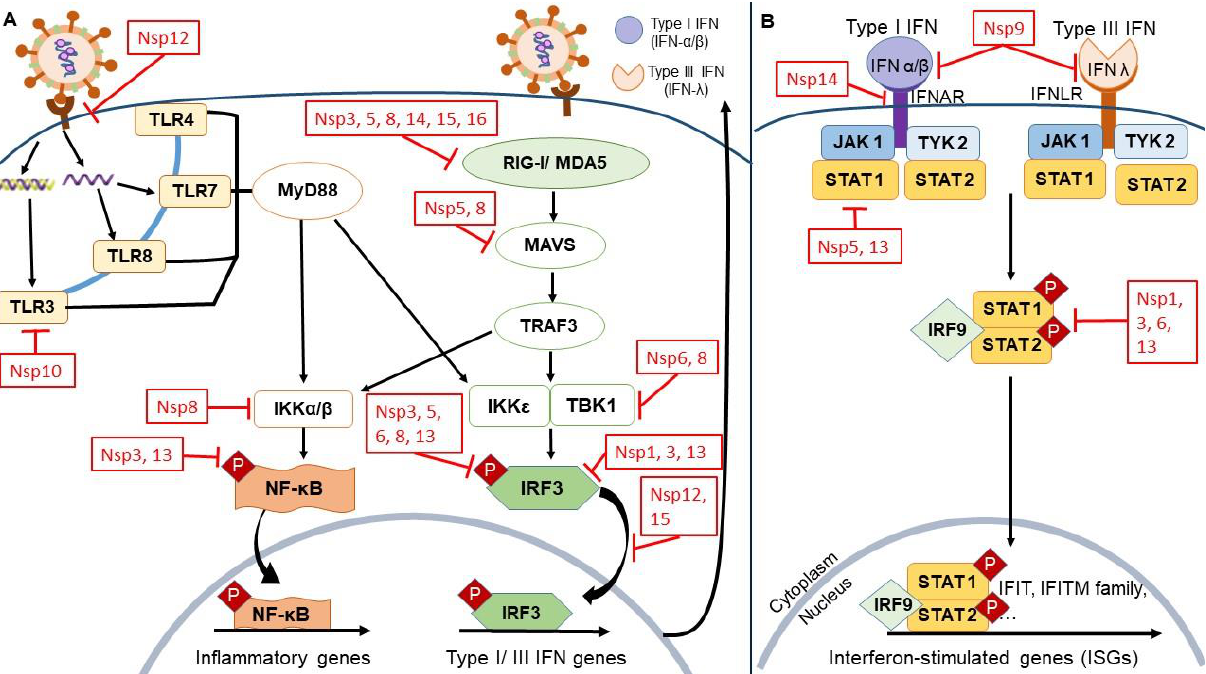
Figure 1. An overview of the SARS-CoV-2 non-structural proteins which contribute to host immune escape (in red boxes). ( A ) Pathogen-associated molecular patterns (PAMPs) of the virus are recognized by various immune cells (macrophages, monocytes, neutrophils, dendritic and epithelial cells). Upon infection, these immune cells recognize foreign viral antigens and molecules (PAMPs) via pattern recognition receptors (PRRs) such as Toll-like receptors (TLRs) and RIG-I-like receptors (RLRs)—thus stimulating cytokines and IFNs, and subsequently inducing host immune responses. ( B ) Type I and type III IFNs are produced and bind to their specific cell surface IFN receptors—thus activating JAK/STAT signaling to promote IFN-stimulated genes (ISGs) to achieve antiviral responses. (Adapted from Park et al.